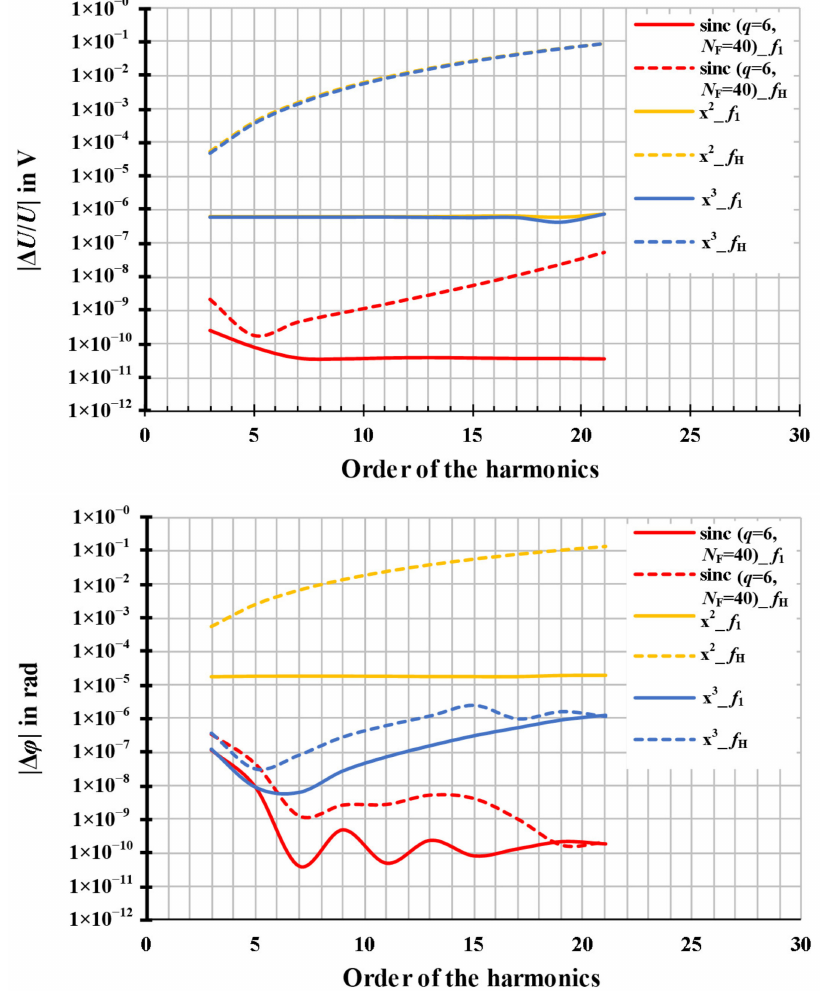
Figure 8. The resampling amplitude and phase error of the fundamental sinus waveform signal with a single harmonic. The signals are simulated with parameters of f S = 4000 Hz, T W = 1 s, U 1 = 1 V, f 1 = 50.1 Hz, ϕ 1 = 0 ◦ , U H = 0.1 U 1 , f H = (2 h + 1) · f 1 , and ϕ H = 0 ◦ , where h is an integer and h = 0, 1, 2, ... , 10, without noise signal. The orange curves represent the results of the interpolation based on the quadratic function. The blue curves represent the results of the interpolation based on the cubic function. The red curves represent the results of the modified sinc